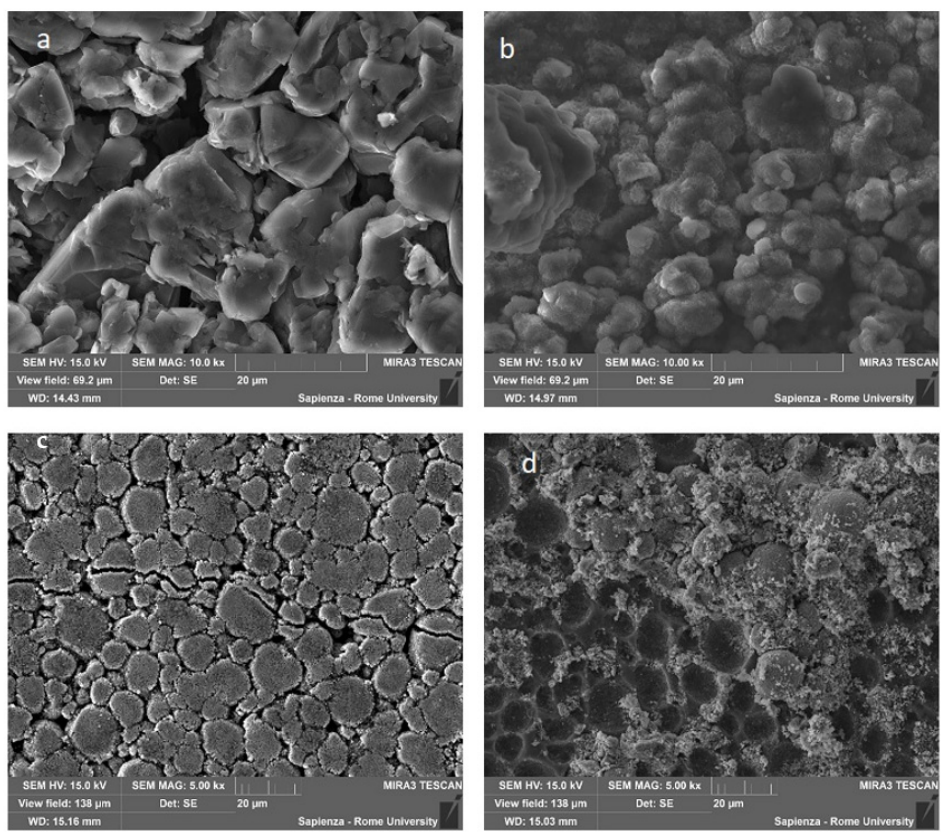
Figure 14. SEM images of cathode (1000 × ) ( a , b ) and of anode (5000 × ) ( c , d ) for a new cell ( a , c ) and cell residues after the cone calorimeter test A4 ( b , d ).